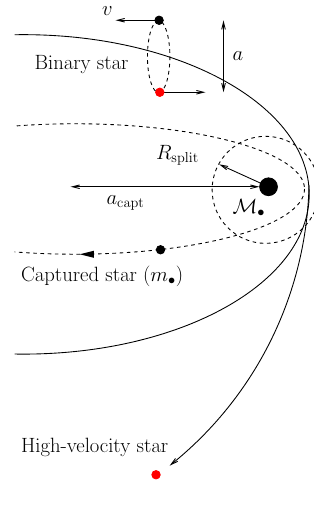
Fig. 50 Schematic illustration of the process of the tidal separation of a binary by a MBH of mass M • . R split is defined as the radius within which the tidal forces of the MBH overcome the binding energy of the